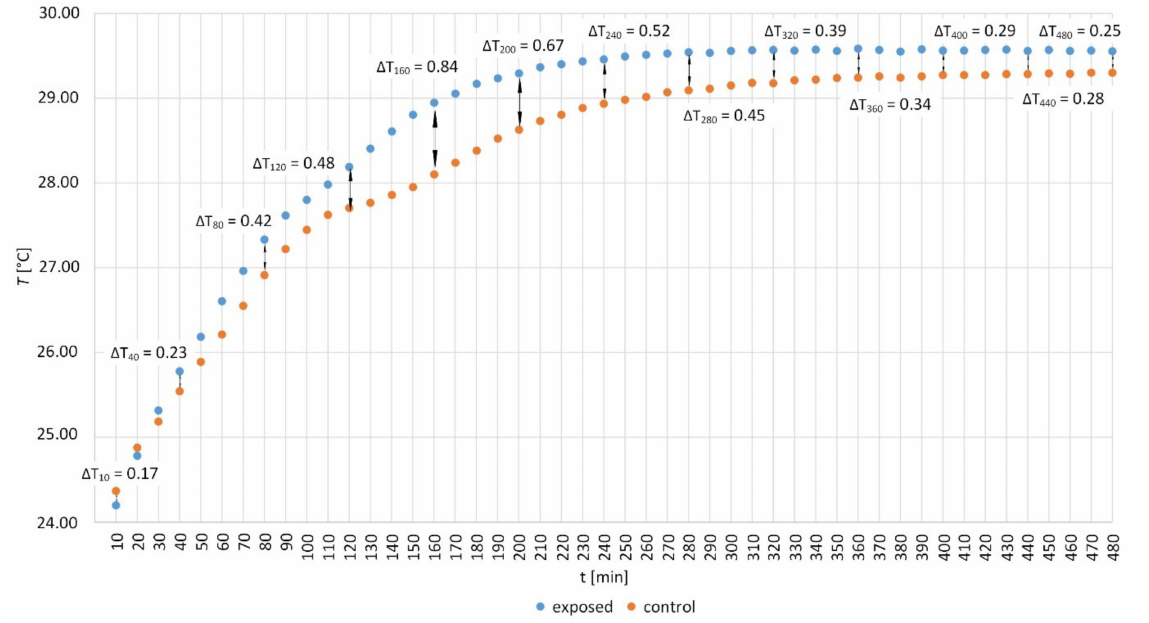
Figure 11. Temperature profile during the experiment, an average of 12 experiments. The low temperature of 24 ◦ C occurring at the start of each experiment is caused due to the opening of the incubator door and manipulation with samples. During the 8 h lasting experiment, the door remains closed. The temperature difference stabilizes after 4 h ( ∆ T260) from the start of the experiment, where the temperature difference between control and exposed samples is less than 0.5 ◦ C, and it is no longer increasing. The temperature of the YPD medium in exposed and control samples is measured before and after each experiment using the conductometer PC 70 Vio. The average YPD temperature difference between control and exposed samples A-E in 12 experiments before and after the experiment is shown in Figure 12.